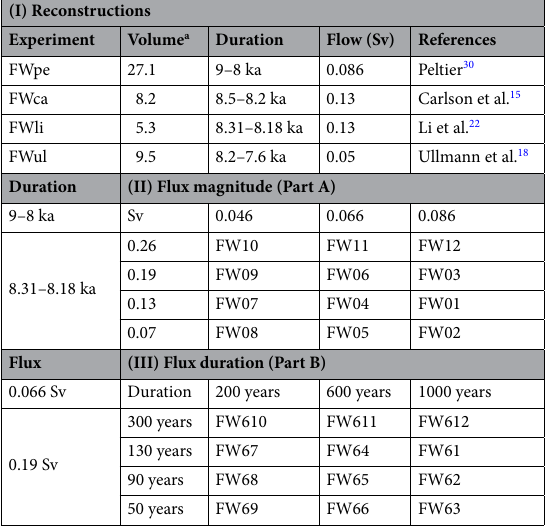
Table 1. Details of simulations used in this study. The reconstructions table (I) describes the meltwater volumes, fluxes and durations for the homogeneous forcing experiments described in “Simulations based on earlier reconstructions” section. Experiments with hybrid freshwater forcing are separated into Part A and B (II and III). The long meltwater flux in the hybrid experiments in Part A have a fixed duration of 1000 years (9–8 ka), and the short flux is fixed at 130 years (8.31–8.18 ka). FW06 is the simulation in best agreement with proxy data in Part A, so the flux magnitudes of FW06 were used in Part B to test flux duration of the short flux. Note that FW06 is the same simulation as FW61. Volume ( a ) is in 10 5 km 3